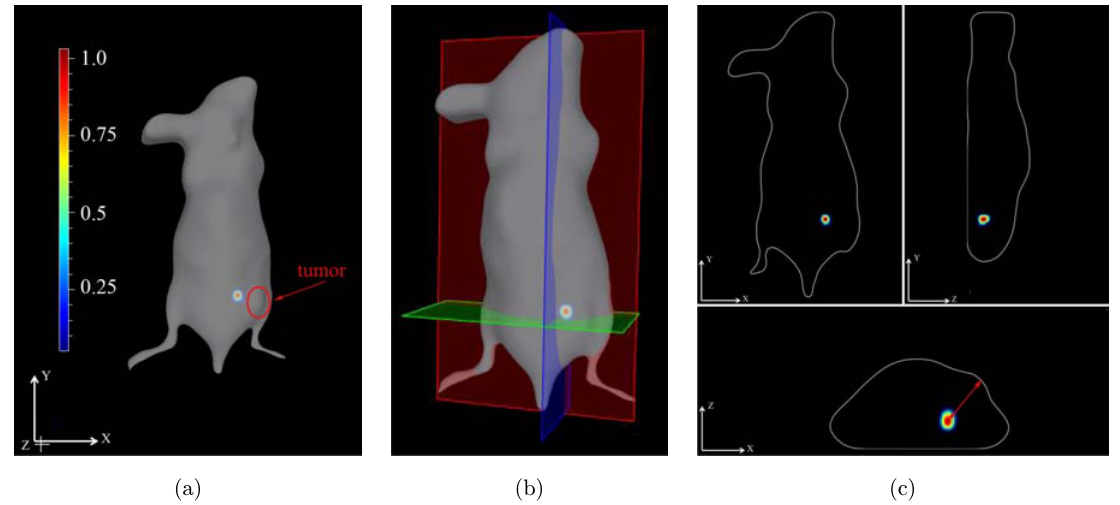
Fig. 5. Reconstruction results of the IVIS Imaging System Spectrum. (a) The 3D tumor lesion reconstruction of the IVIS Imaging System Spectrum. The true tumor location is indicated by the red circle and arrow. The reconstructed light source is inside the mouse body but not inside the true tumor lesion. (b) – (c) The coronal, sagittal and transversal slices were extracted from the IVIS Imaging System Spectrum dataset, within the same X-Y-Z coordinate. The red arrow was the minimum distance between the reconstructed tumor center and the true tumor surface on the transversal